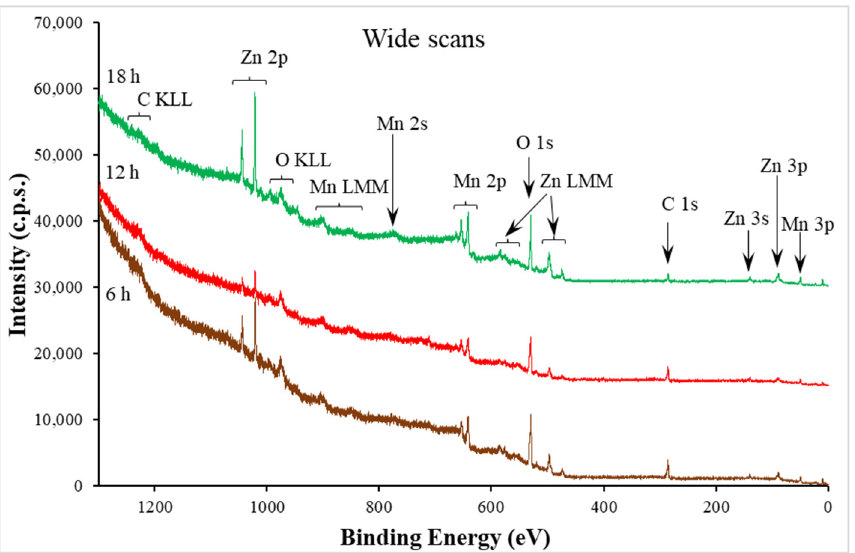
Figure 4. Wide spectra of ZnMn 2 O 4 samples obtained at different times, 6 h (brown), 12 h (red), and 18 h (green).